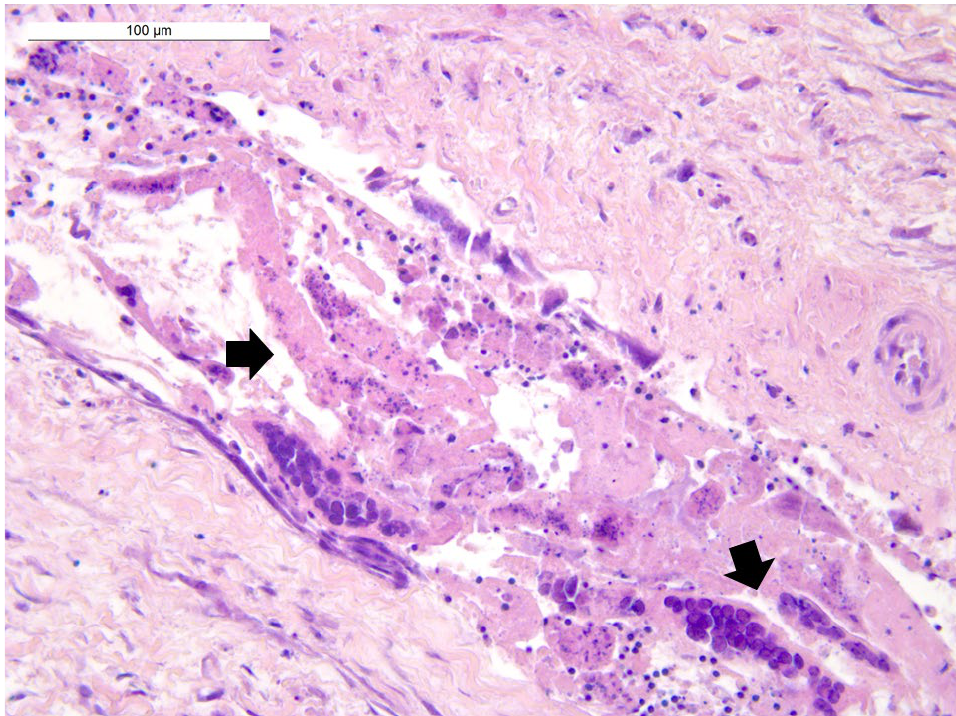
Figure 4. Air sac: fibrinous exudate and necrotic debris admixed with multinucleated syncytial cells and mild heterophilic infiltration in the air sac lumen (arrow). Hematoxylin and eosin (4× objective). Bar = 100 µm.